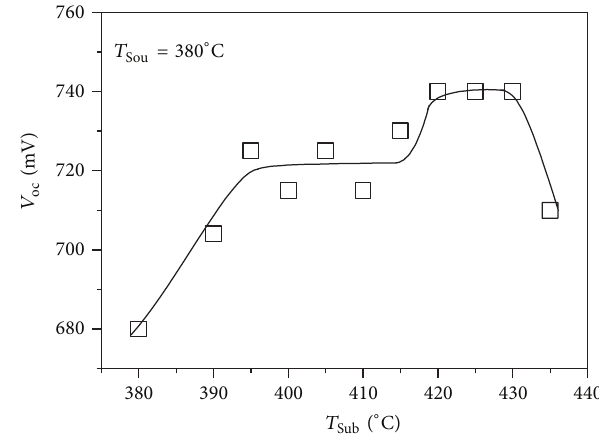
Figure 5: Thermal annealing in CdCl 2 vapor of the CdTe/CdS/CIO/glass part of the cell. 𝑇 was varied in the range 380–435 ∘ C. PP and 𝑇 Sub was kept constant at 20 min. Lines joining the experimental points were outlined only as a visual guide to the eye. for each O 2 OC = 380 ∘ C and Sou